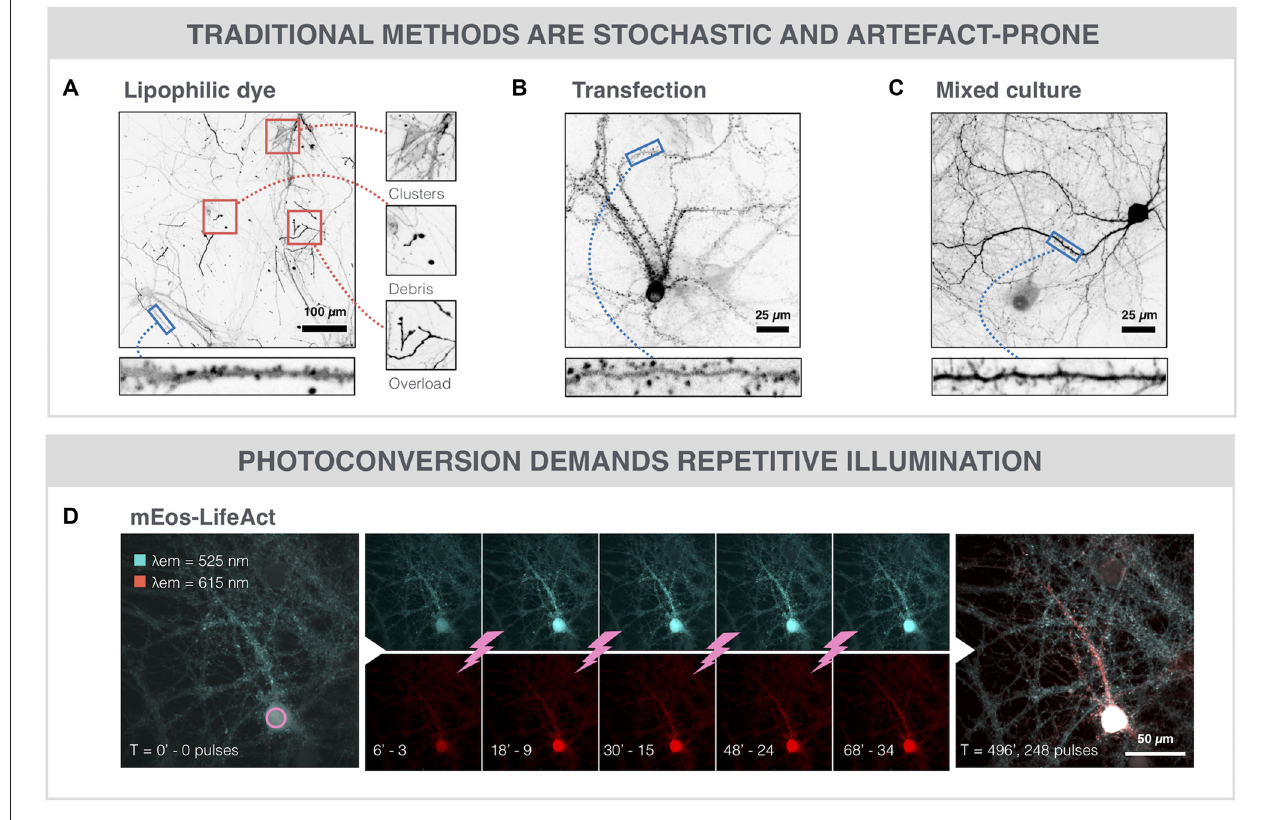
FIGURE 3 | SNAP outperforms alternative labeling strategies. (A) The lipophilic dye DiI enables sparse, but stochastic labeling of neurons within the neuronal network. It suffers from drawbacks such as clustered staining of adjacent neurons, debris, and uneven dye loading or overloading. (B) Microscopic image of a neuron transduced with actin-RFP (BacMam vector). Spines can clearly be resolved since actin is highly enriched in spines. However, the overexpression of actin-RFP may lead to artifacts such as enlarged spine heads (see also Supplementary Figure S1B) or increased cellular stress. (C) Microscopic image of a Thy1-YFP neuron in a mixed culture with non-labeled WT cells (1:5 ratio). Spines can be discerned, but the signal of YFP in spines is weak and the labeled cell distribution is stochastic. (D) Photoconversion of mEos-LifeAct (cyan) in a primary neuron. Every 2 min, a 405 nm photoconversion pulse is delivered to the soma of the selected neuron, leading to a gradual spreading of the photoconverted (red) variant throughout the